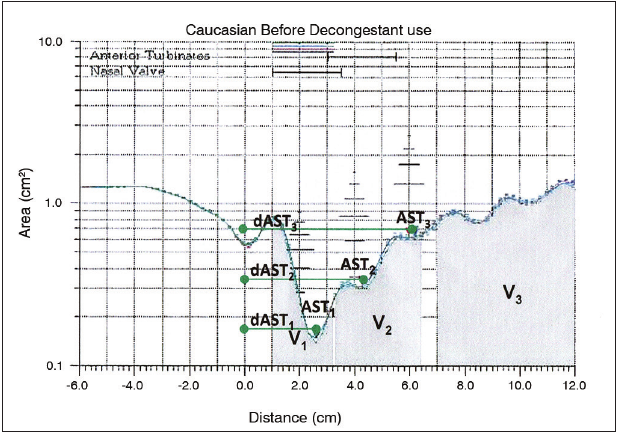
Figure 2. Typical rhinogram of a patient with nasal obstruction, showing the sites used to measure cross-sectional areas (CSA), distance from nostrils (dCSA), and nasal volumes (V).